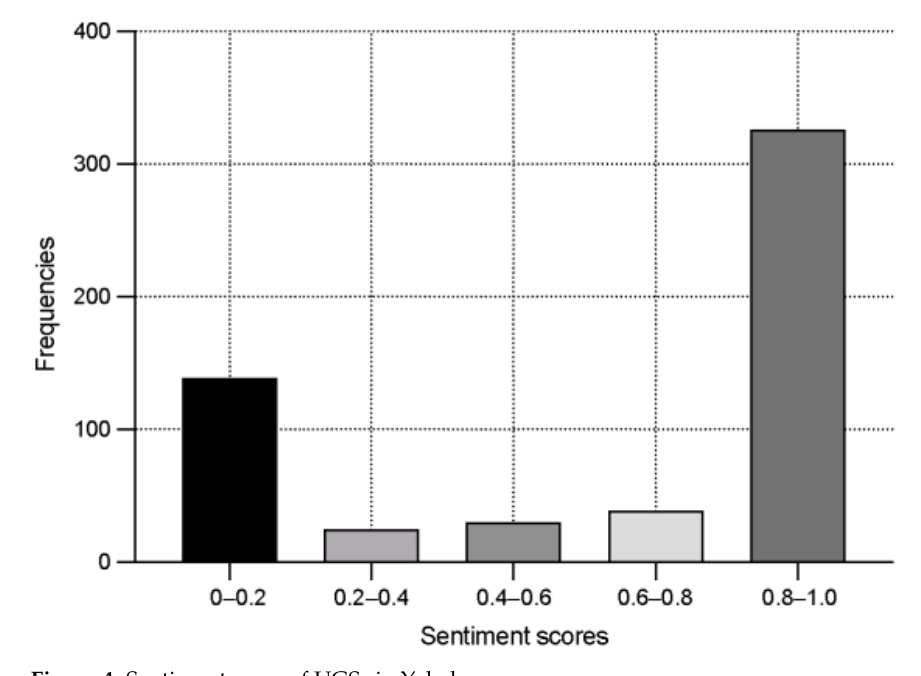
Figure 4. Sentiment score of UGSs in Yokohama.